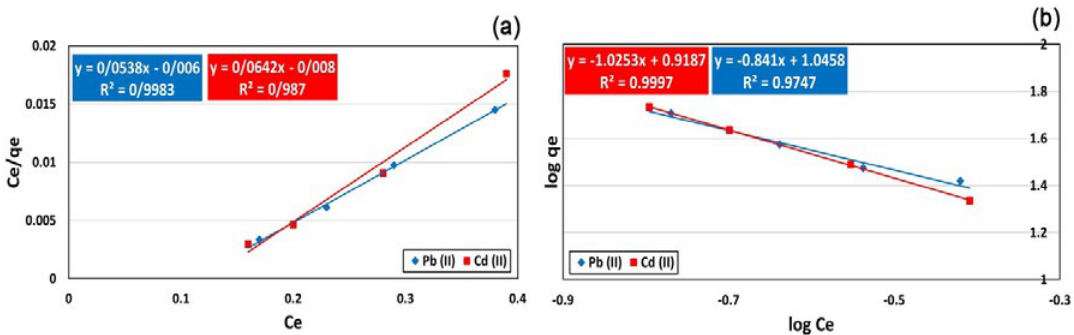
Fig. 9. (a) Langmuir and (b) Freundlich models of Pb 2+ and Cd 2+ adsorption with zeolite N.P./PEG/GO nano-composite